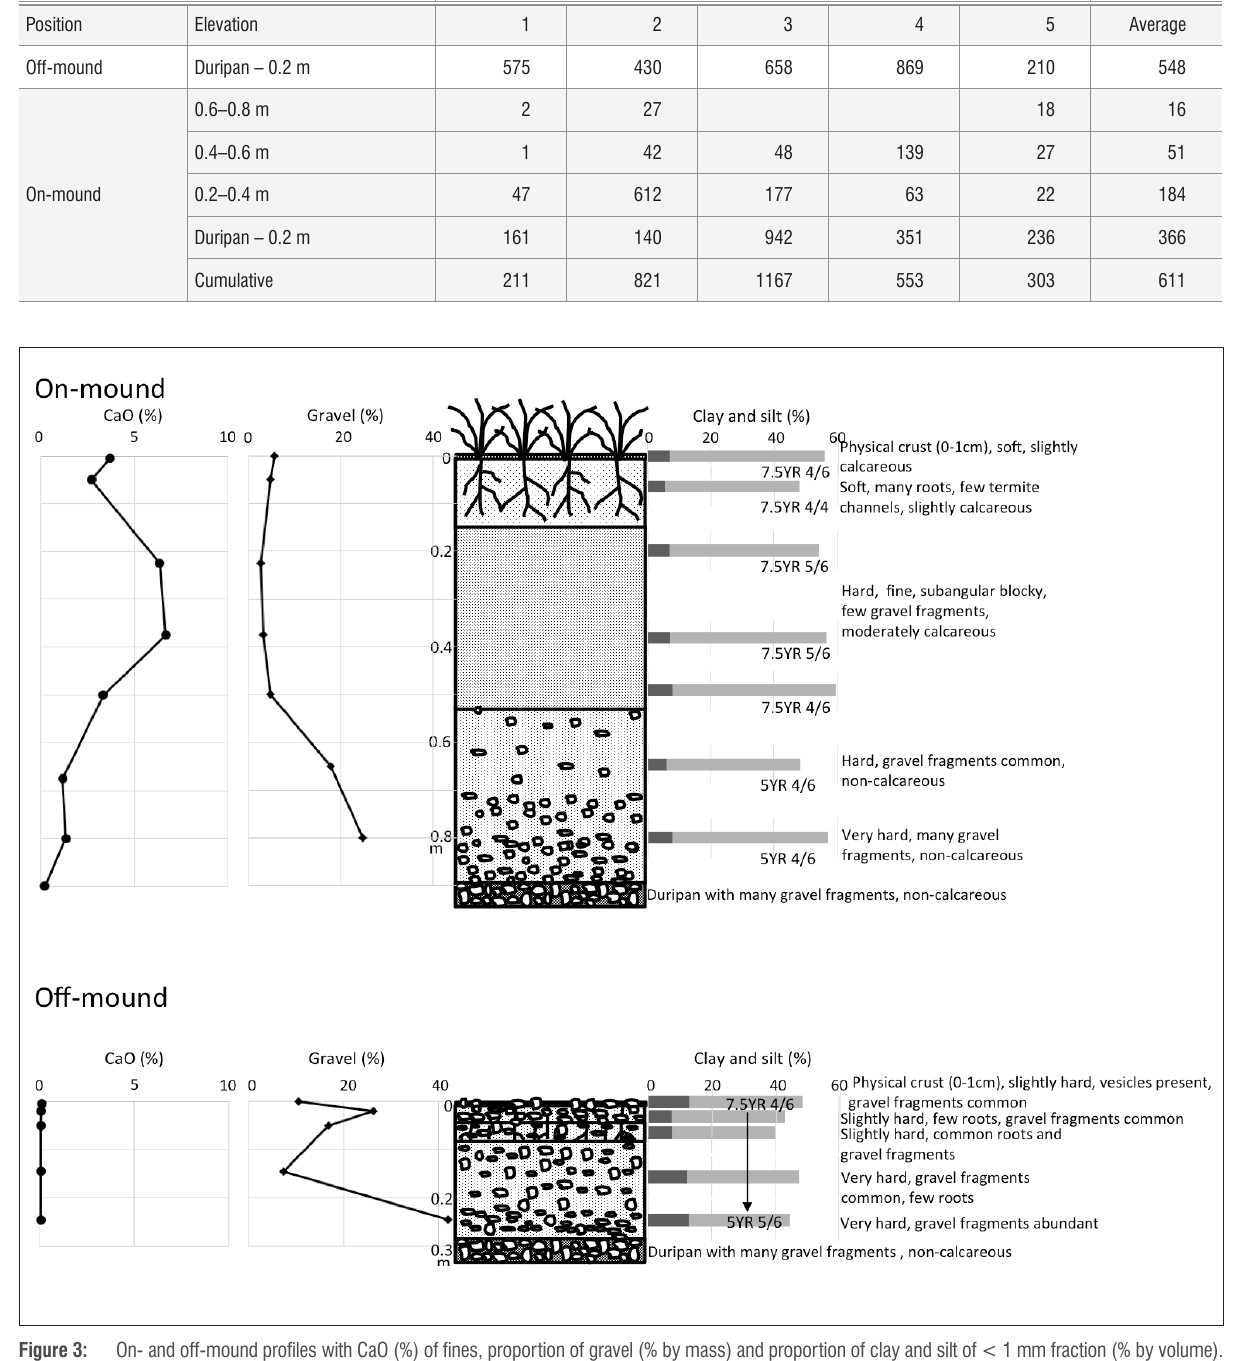
The variation in the concentration of gravel (kg/m 3 ) with elevation in the soil profile above the duripan layer of excavated mounds and corresponding off-mound areas ( n =5). The cumulative concentration of gravel on-mound is shown for comparison with the off-mound gravel, and the concentrations have also been averaged across mounds. Two of the mounds excavated were less than 0.6 m above the duripan layer in height. Mound